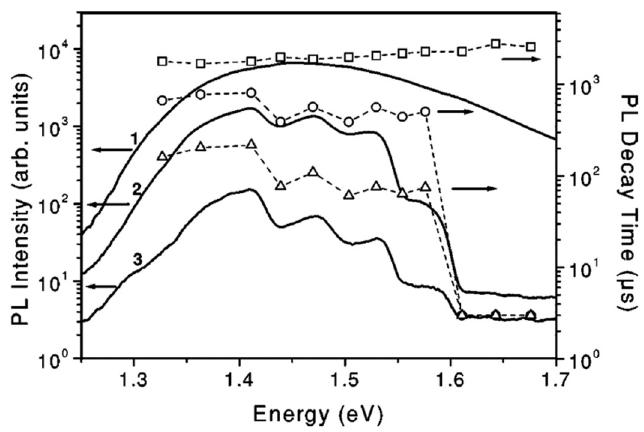
Figure 23. PL spectra (curves) of por-Si and the corresponding spectral dependences of the PL decay time (symbols) for different strength of the quenching induced by O 2 molecule adsorption at T = 5 K: in vacuum (curve 1, squares), intermediate level of the quenching (curve 2, circles) and strong quenching (curve 3, triangles). (From Reference [65]).